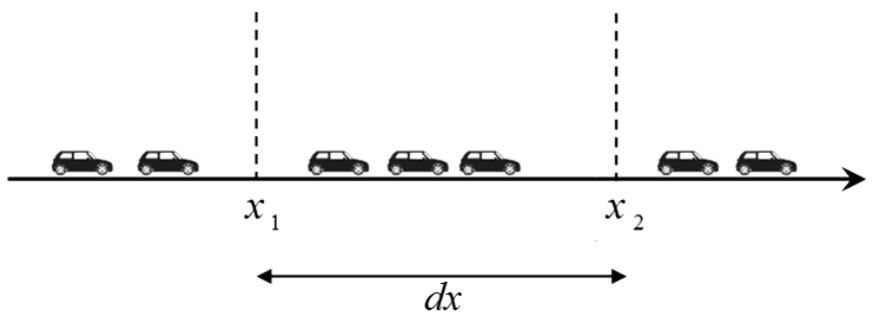
RS in a moving traffic. NOV from x 1 to x 2 ρ ( x , t ) = dx NOV from t 1 to t 2 Q ( x , t ) =